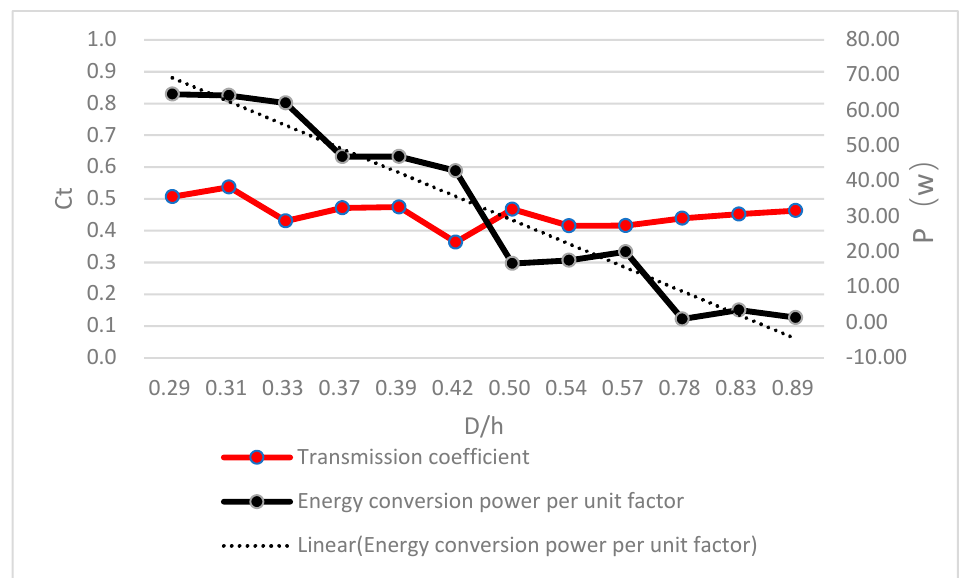
Figure 16. Data analysis diagram.